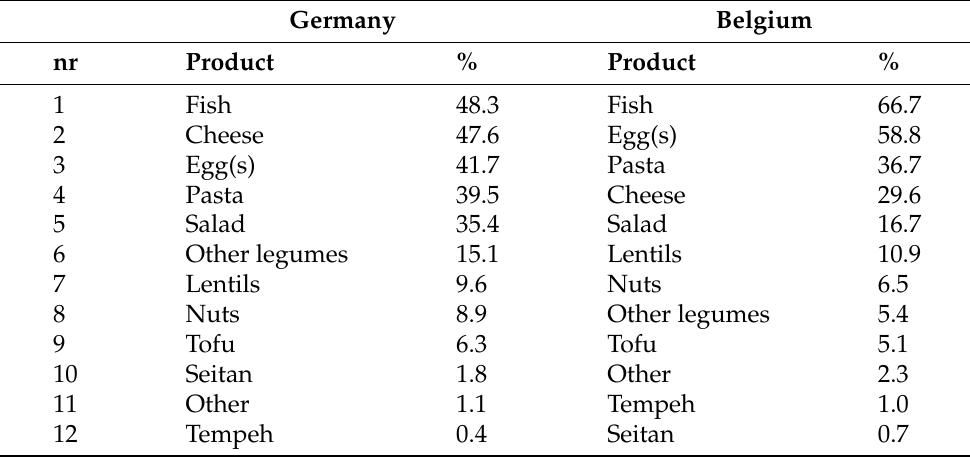
Table 9. Ranking list of consumed meat alternatives.